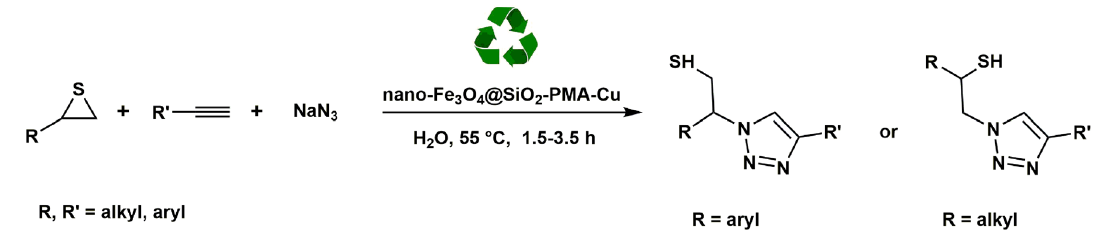
Figure 1. Preparation of β -thiol-1,2,3-triazoles from various thiiranes in the presence of Fe 3 O 4 @SiO 2 -PMA-Cu